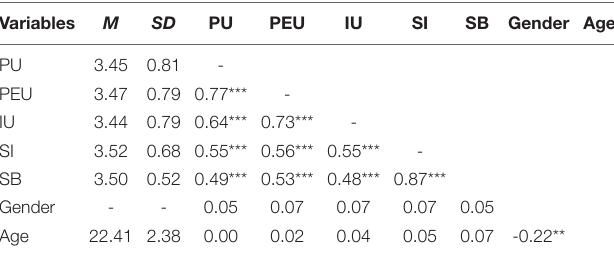
TABLE 1 | Means, standard deviations, and correlations among the main